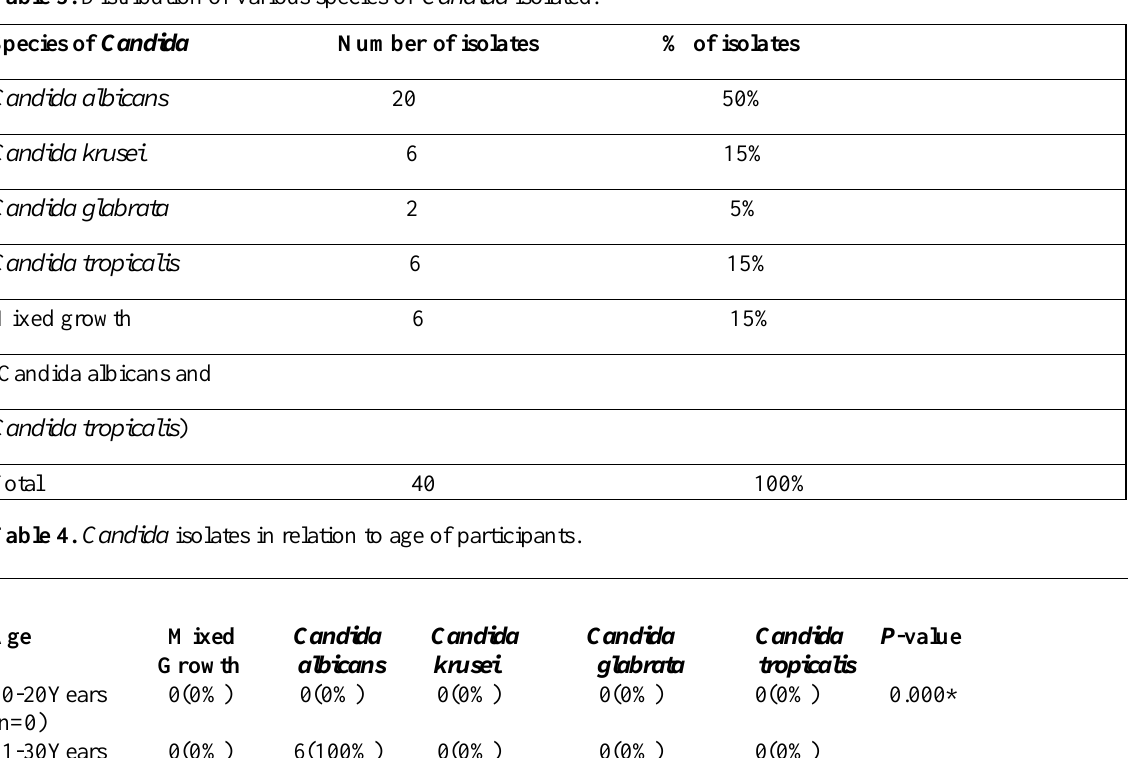
Table 3. Distribution of various species of Candida isolated.